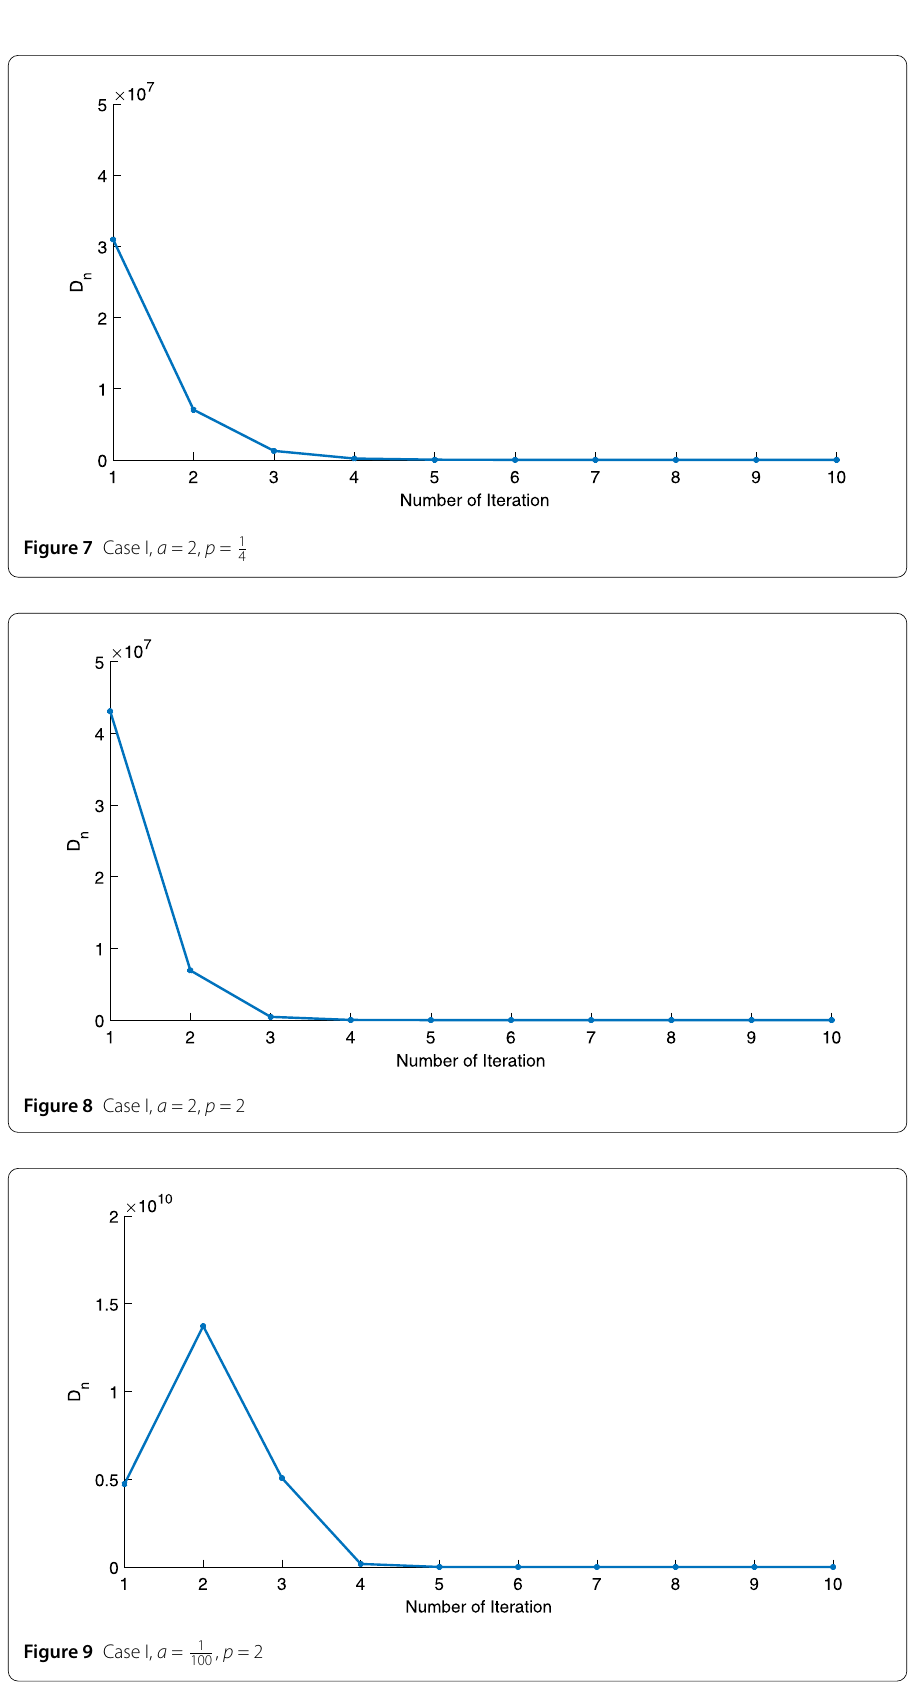
Figure 9 Case I, a = 1